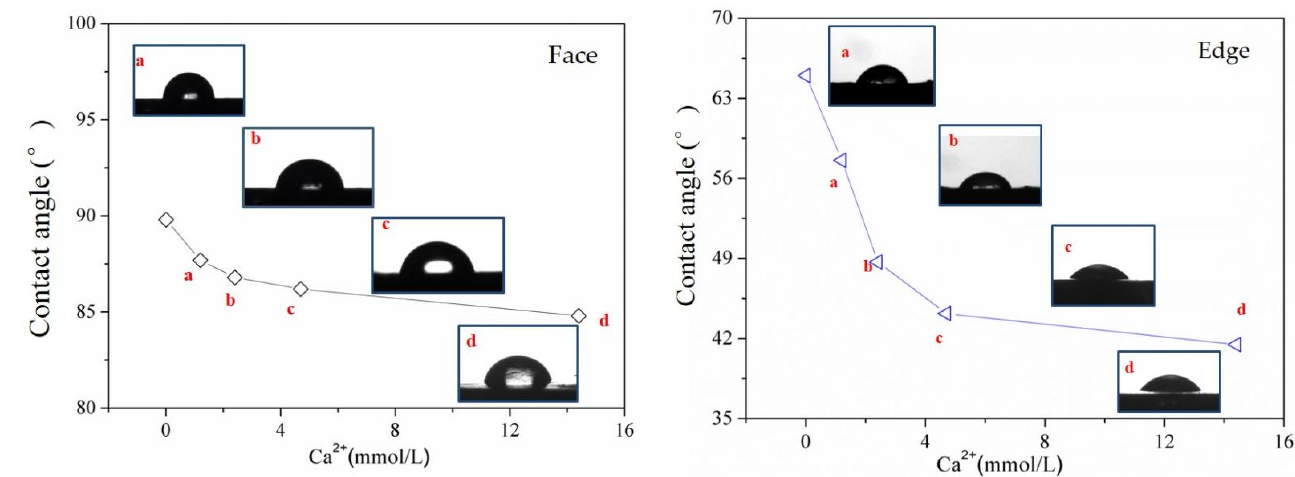
Figure 5. Contact angles of molybdenite surface with calcium ions concentration.